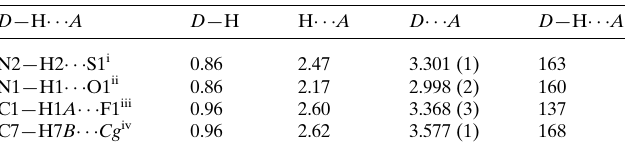
Table 1 Hydrogen-bond geometry (A˚ , (cid:2) ). Cg is the centroid of the C8–C13 ring.